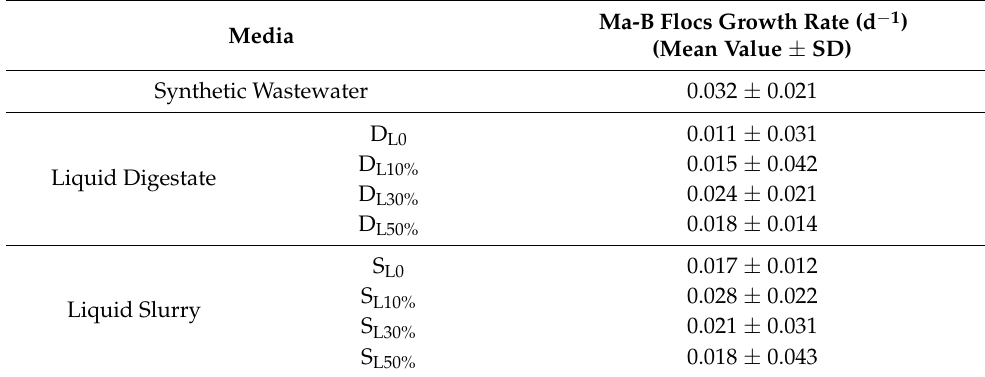
Table 4. Specific growth rate (d − 1 , mean value ± SD) of batch culture for Ma-B flocs using liquid digestate and slurry (with and without dilution) as culture medium compared to synthetic wastewater.